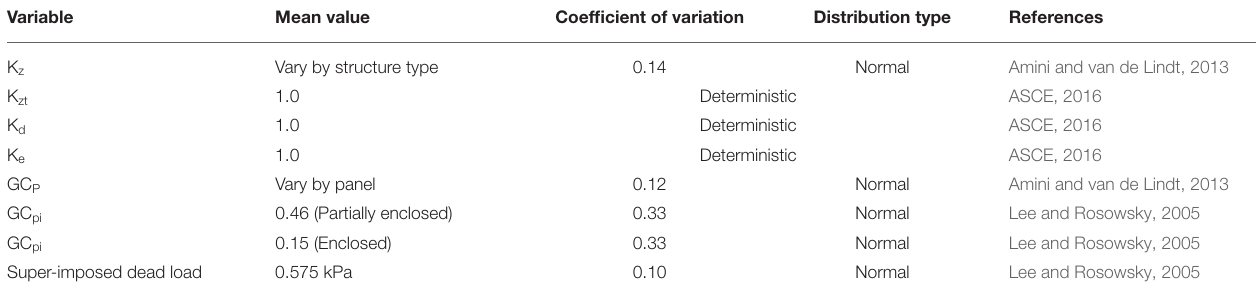
TABLE 3 | Summary of values used in wind analysis.